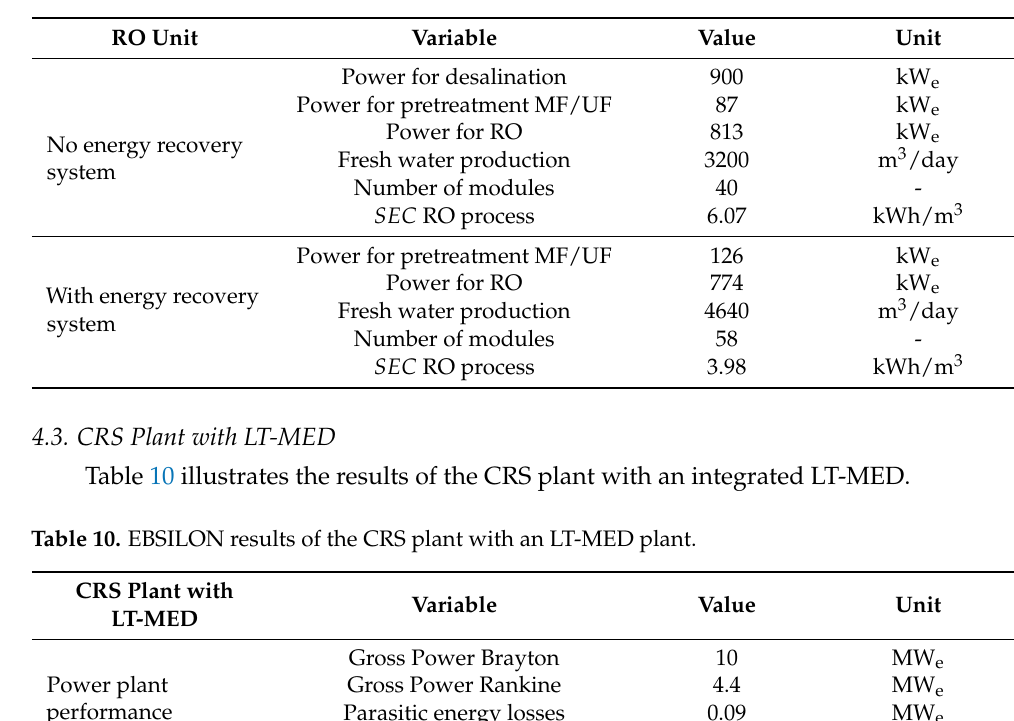
Table 9. Results for the RO plant.